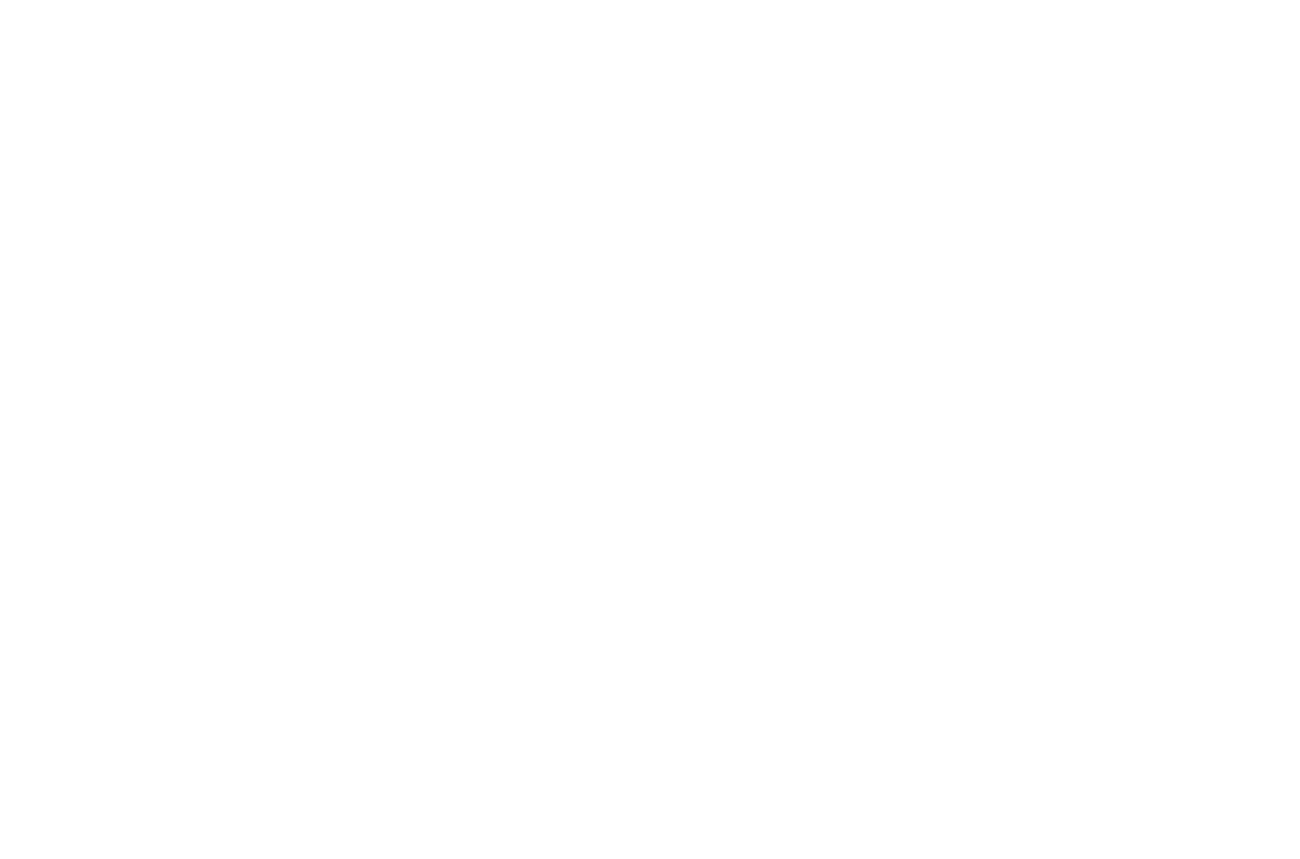
Frontiers in Sustainable Food Systems | www.frontiersin.org